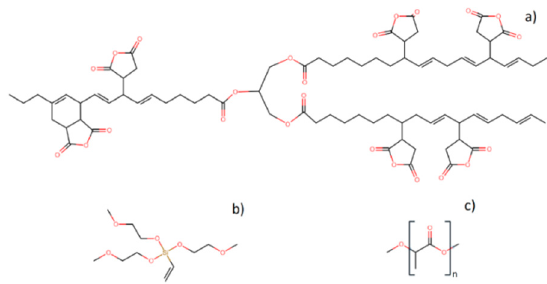
Figure 1. Chemical structure of ( a ) maleinized linseed oil (MLO), ( b ) tris(2-methoxyethoxy)(vinyl) silane (TVS), and ( c ) poly(lactic acid) (PLA).